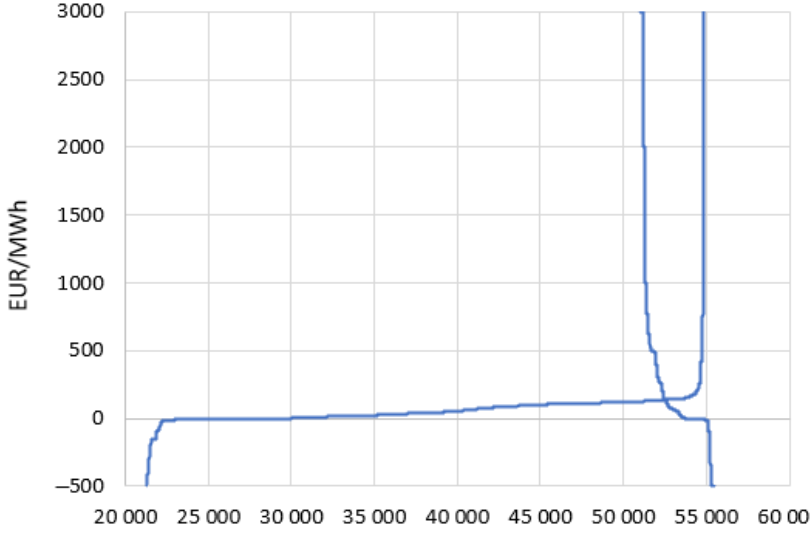
Figure 7. Nordic system supply and bid curves from hour 7 on 7 December 2021.